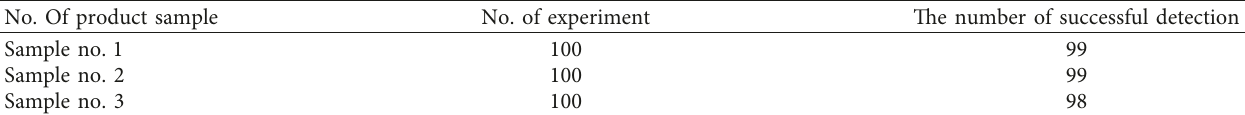
Table 3: The accuracy of the detection of the